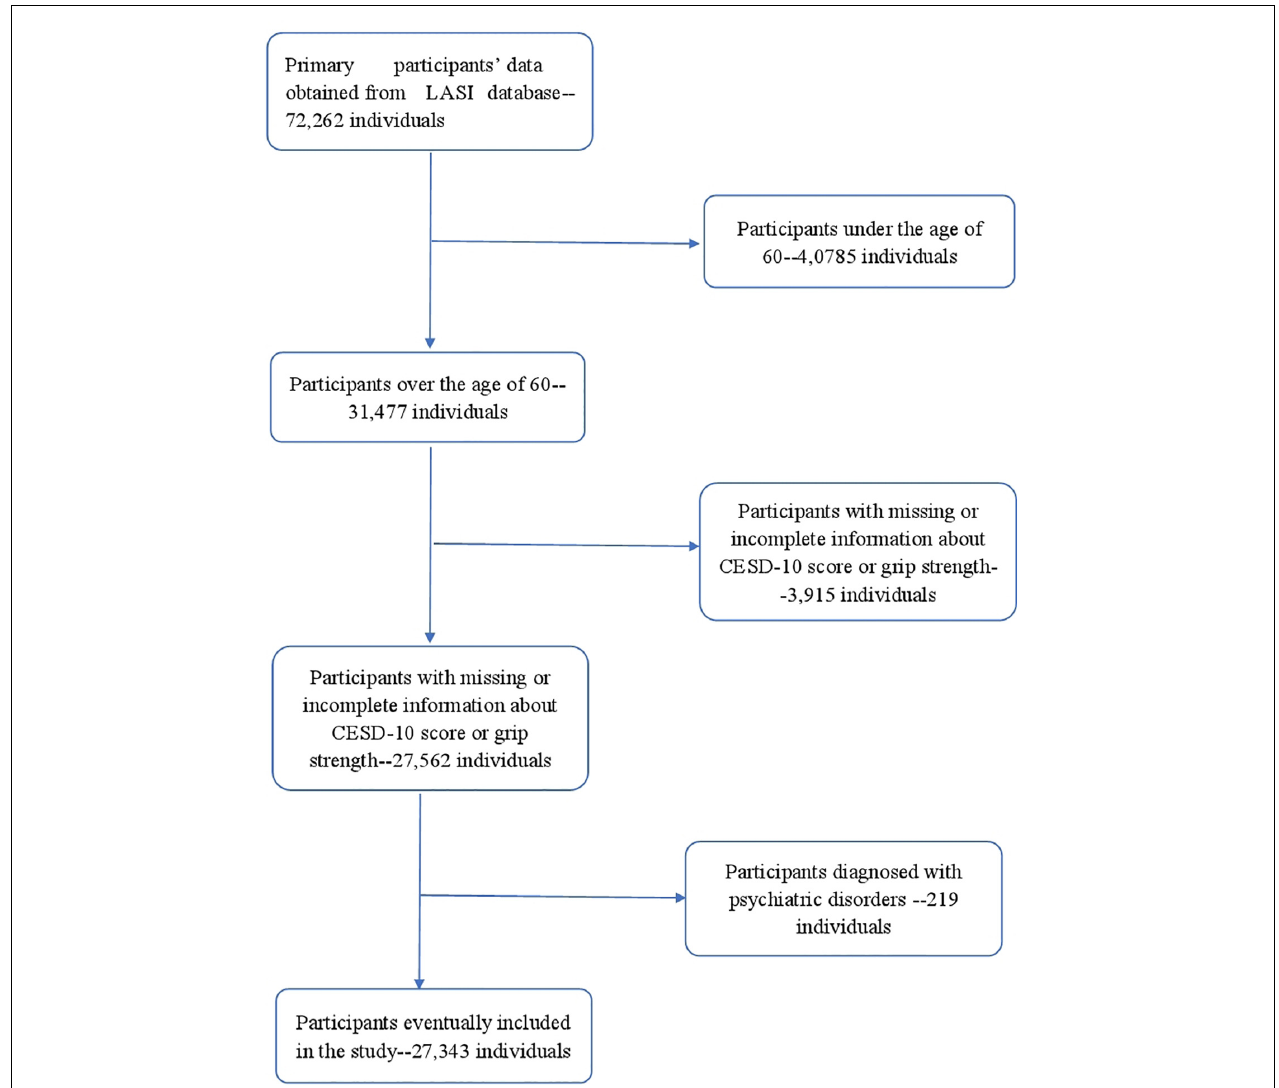
FIGURE 1 | Flowchart of participant